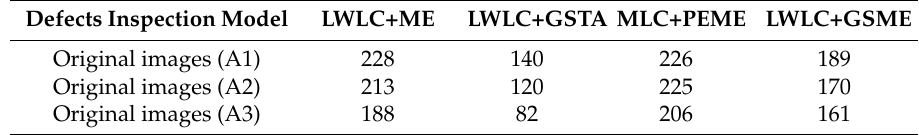
Table 2. Examples of segmentation threshold values with four segmentation methods; LWLC: The proposed Local Weber-like Contrast algorithm; ME: The maximum entropy algorithm; GSTA: The gray stretch and threshold algorithm; MLC: The Michelson-like contrast algrorithm; PEME: The proportion emphasized maximum entropy method; GSME: The gray stretch maximum entropy